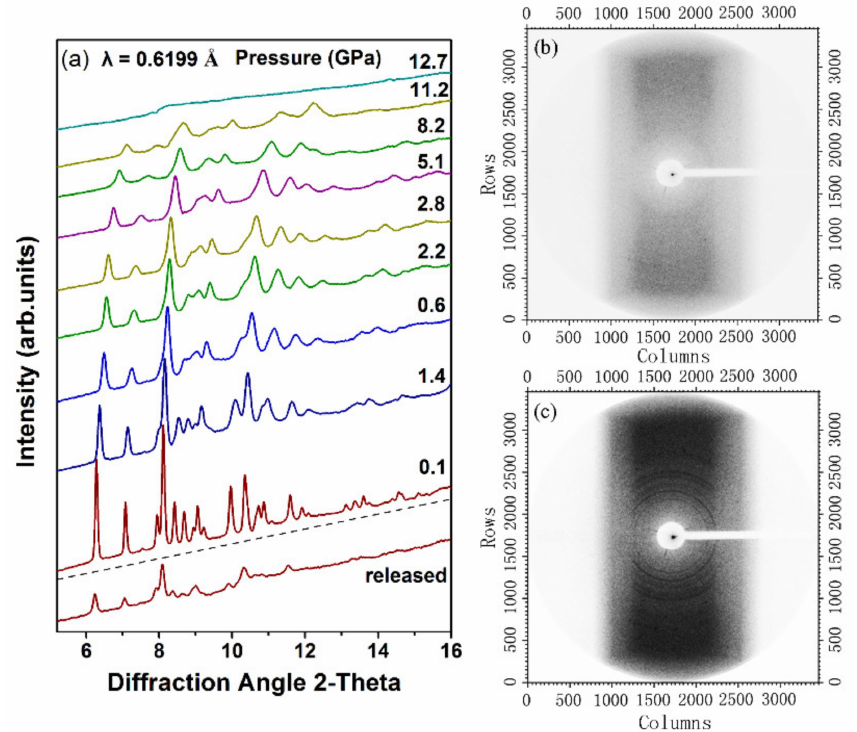
Figure 9. Synchrotron XRD patterns of PC form-I under different pressures ( a ). Diffraction images of PC form-I compressed under 12.7 GPa ( b ) and decompressed under ambient pressure ( c ). Reprinted with permission from Ref. [97]. Copyright 2017 American Chemical